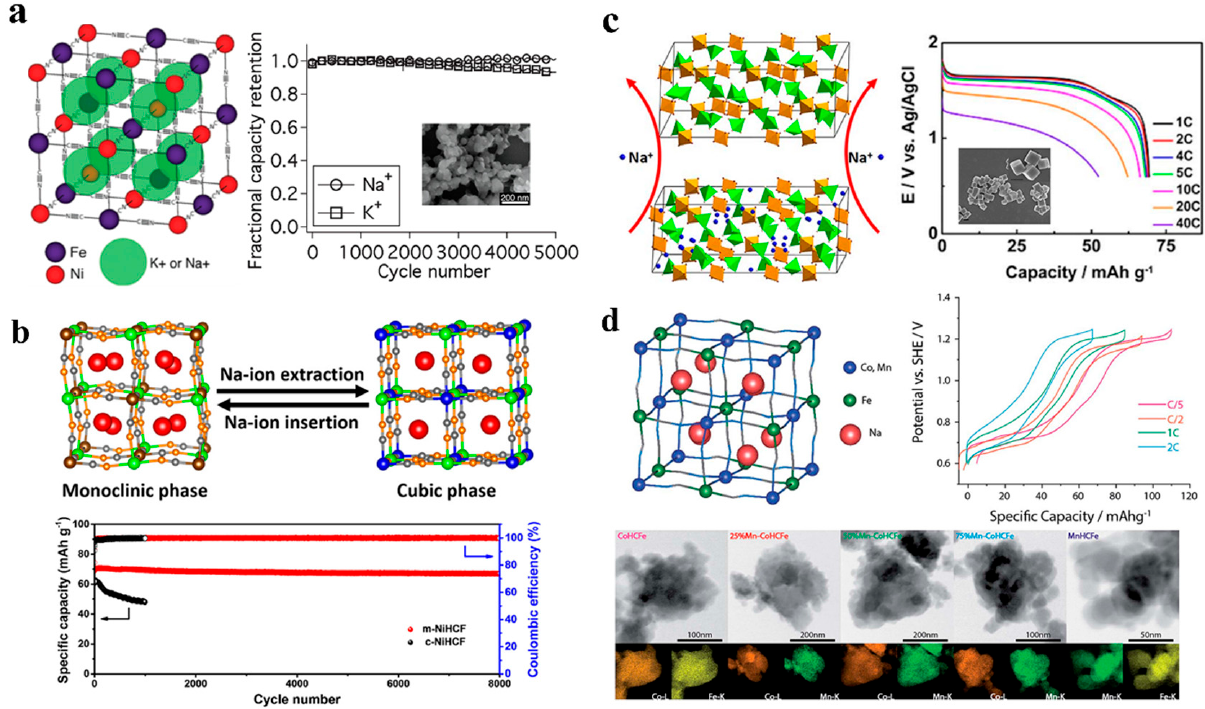
Figure 7. ( a ) NiHCF crystal structure with no capacity loss after 5000 cycles. Reproduced with the permission of ref. [76], copyright 2011 American Chemical Society ( b ) The good electrochemical performance of m − NiHCF as a cathode material for ASIBs. Reproduced with the permission of ref. [77], copyright 2020 Elsevier B.V. ( c ) ZnHCF schematic illustration of sodium-ion intercalation. Reproduced with the permission of ref. [78], copyright 2018 Elsevier B.V. ( d ) Physicochemical char- acterization and battery performance of the Mn − CoHCFe solid solutions. Reproduced with the permission of ref. [82], copyright 2016 The Royal Society of Chemistry.